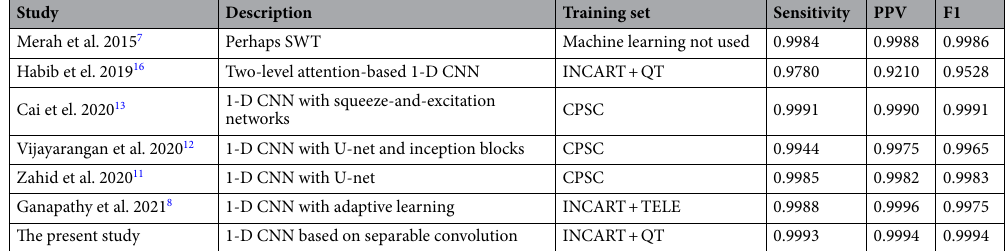
Table 2. Model performance in the MIT-BIH database by cross-database validation. CPSC China Physiological Signal Challenge database 33 , TELE Telehealth electrocardiogram recordings 25 .